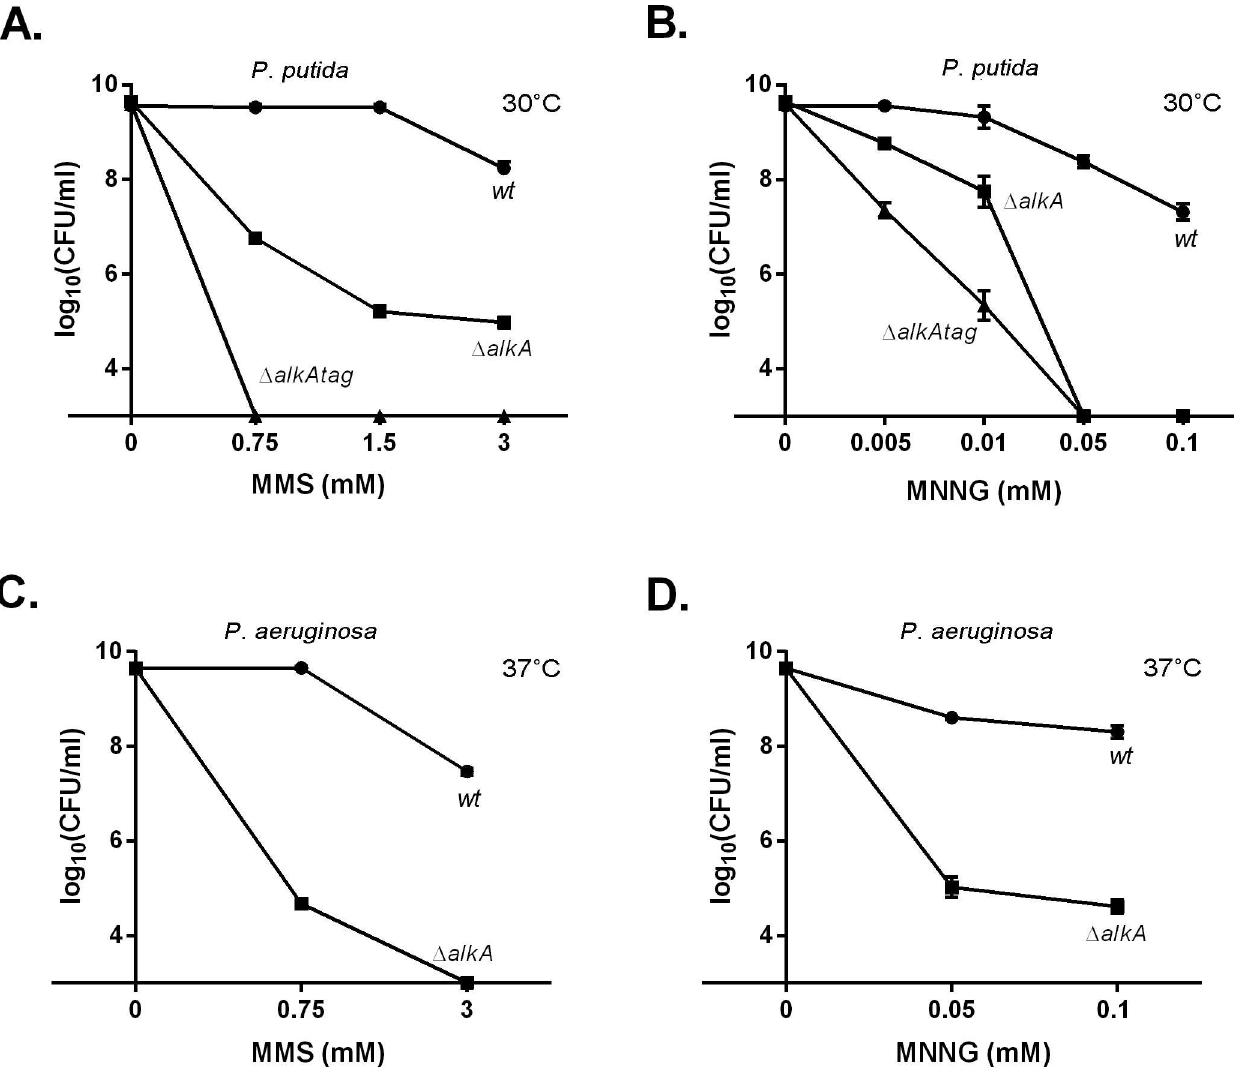
Fig 3. Sensitivity of P . putida and P . aeruginosa wild-type and their DNA glycosylase-deficient derivativesto MMS and MNNG. Sensitivity was estimated by spotting 10-fold dilutionsof overnight cultures of P . putida (A, B) and P . aeruginosa (C, D) onto LB plates containing different concentrations of MMS (A, C) and MNNG (B, D). Data representsthe mean ( ± 95%CI) values. ( ● ) wild-type;( ■ ) Δ alkA ; ( ▲ ) Δ alkAtag . P . putida was incubatedat 30˚C and P . aeruginosa was incubatedat